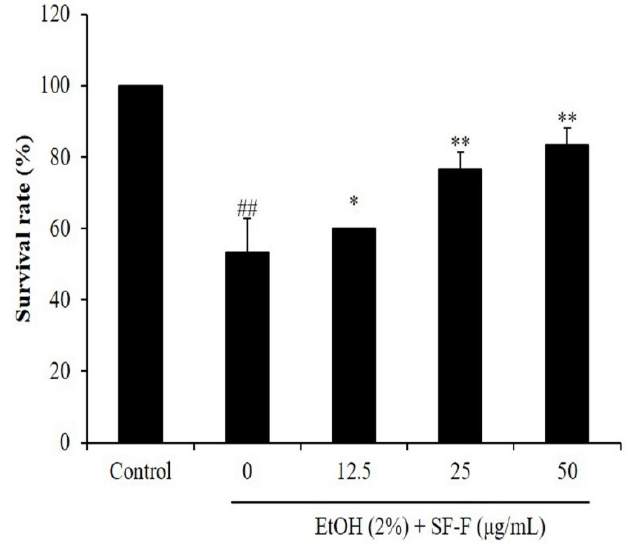
Figure 3. The survival rate after pretreatment with SF-F and/or co-treatment with EtOH in zebrafish. The data are expressed as the mean ± SE. * p < 0.05, ** p < 0.01 as compared to the EtOH-treated group and ## p < 0.01 as compared to the control group.